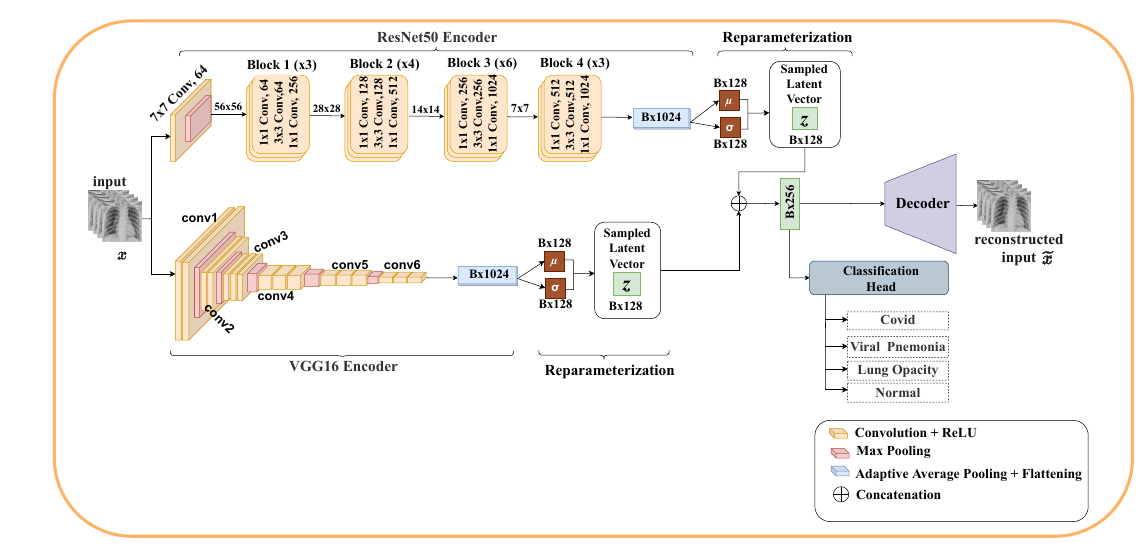
Figure 3. Model Two: Each encoder performs its own reparameterization to generate its own latent embedding z . The latent embeddings are then merged and passed as input to the decoder and classification head for reconstruction and classification of pneumonia, respectively.